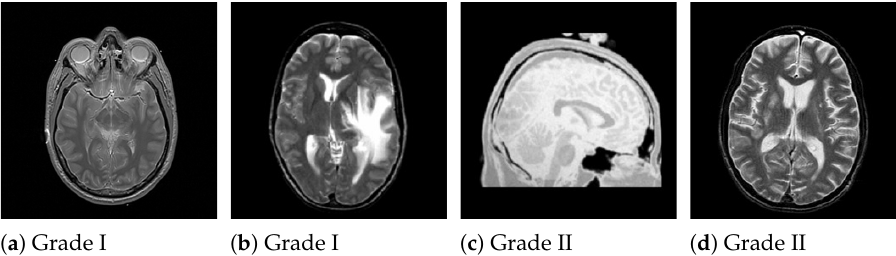
Figure 2. Examples of non-meningioma benign brain images.